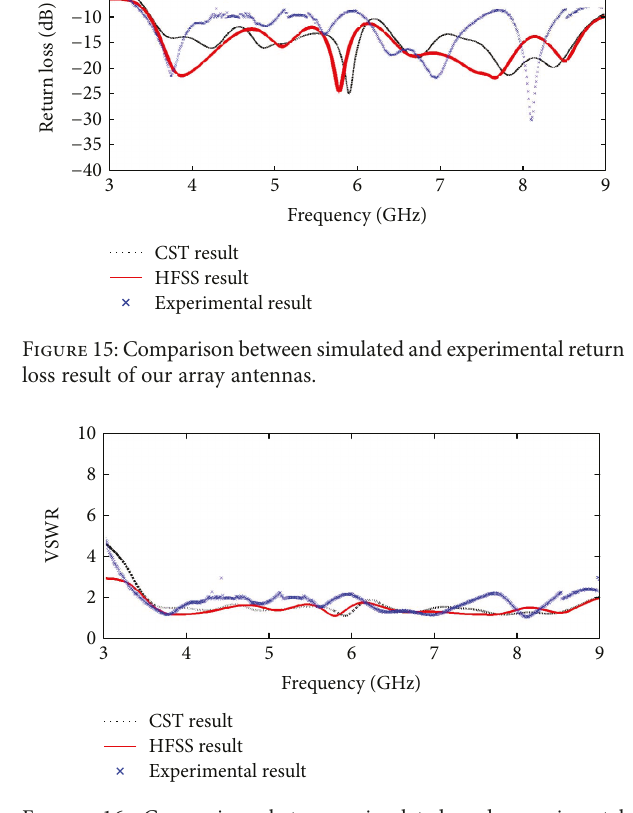
Figure 16: Comparison between simulated and experimental VSWR result of our array antennas.